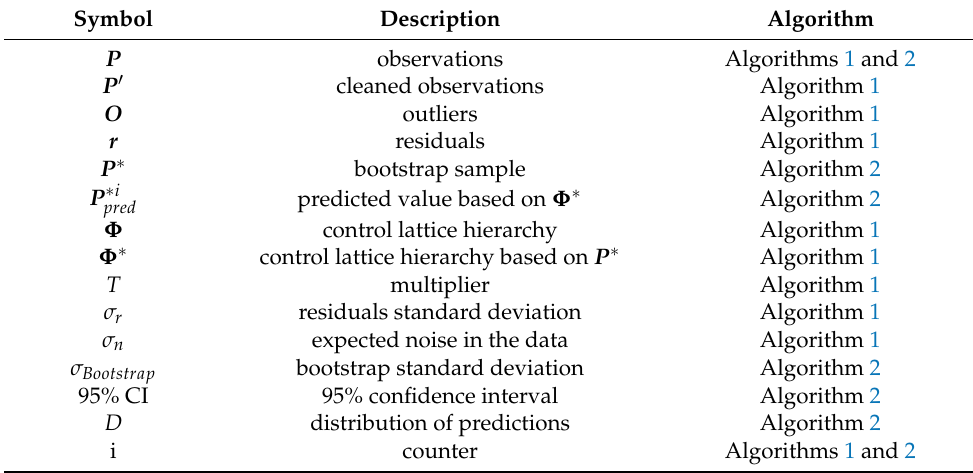
Table A1. Overview of the used symbols in Algorithms 1 and